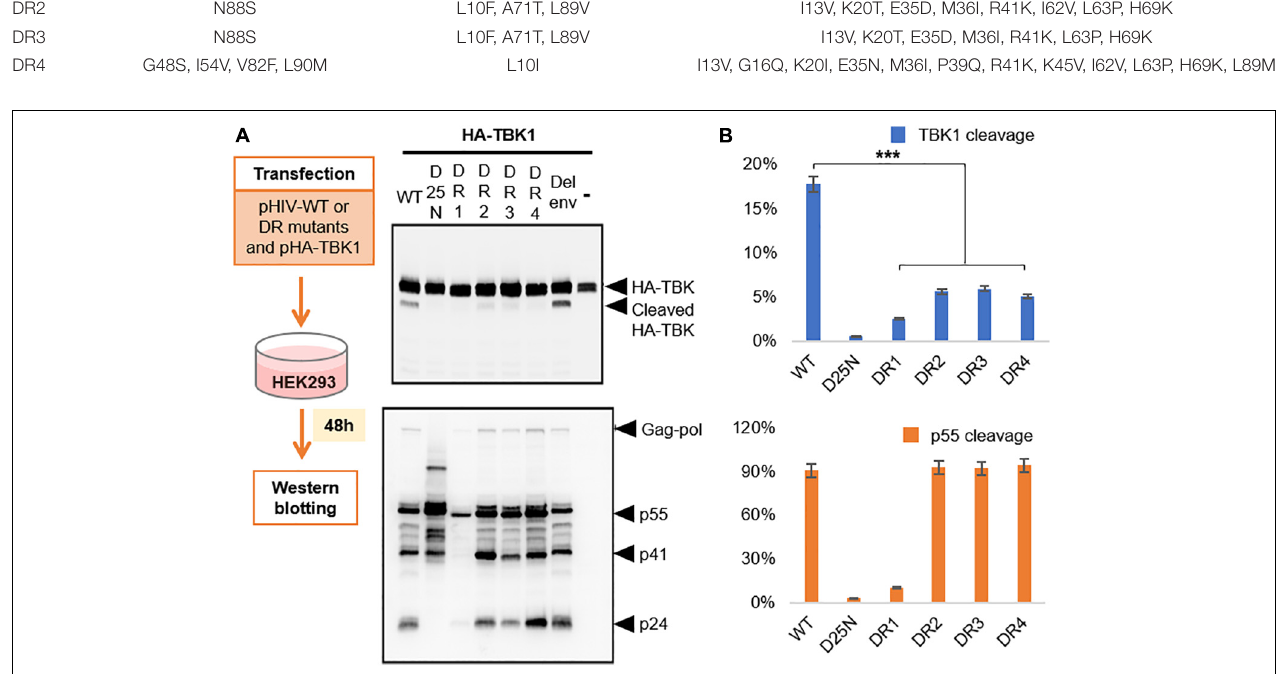
FIGURE 5 | Drug resistant proteases cleave TBK1 ineffectively. (A) Wild type HIV or either of the four drug resistant mutants listed in Table 1 were co-transfected with HA tagged TBK1. Western blot analysis done after 48 h to observe TBK1 cleavage bands with anti-HA antibody and p55 cleavage bands with anti-p24 antibody. (B) Quantification of band intensities from (A) . Graph on the top indicates cleavage ratio percentage of cleaved TBK1 over un-cleaved TBK1 while the one on the bottom indicates that of p24 over p55. *** indicates p -value <